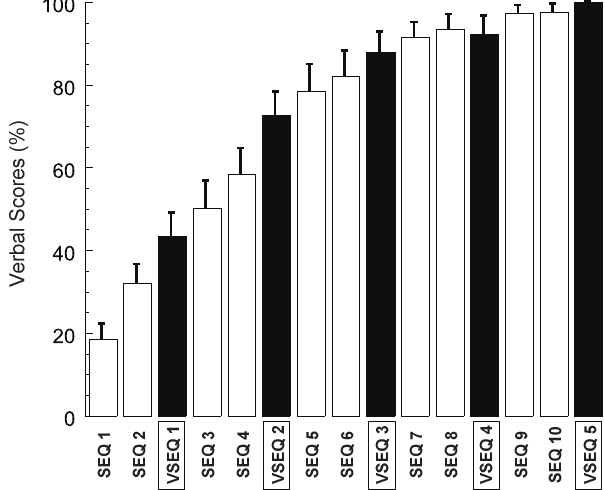
Figure 2. Behavioral results. Mean Verbal Score ( 6 SE) are plotted in percentage per each SEQ (white columns) and VSEQ (black columns) block.